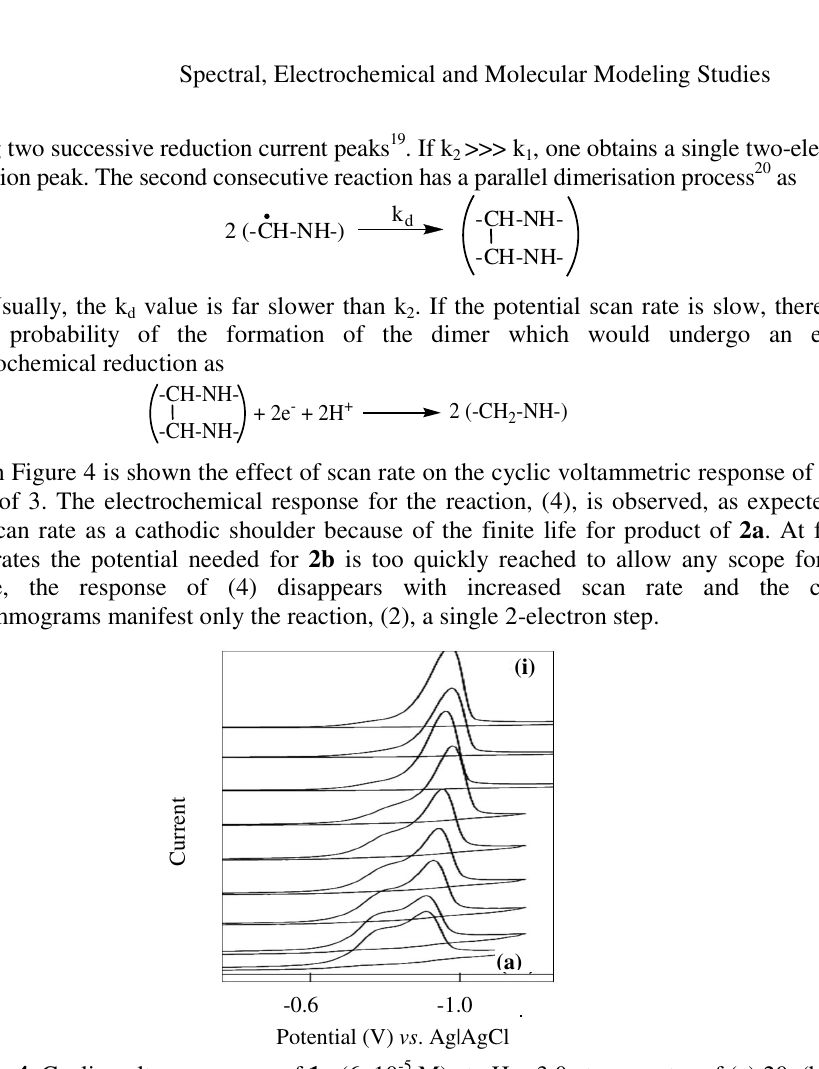
Figure 4. Cyclic voltammograms of 1a (6 x 10 -5 M) at pH = 3.0 at scan rates of (a) 20, (b) 50, (c) 100, (d) 200 (e) 500, (f) 1000, (g) 2000, (h) 4000 and (i) 5000 mV s -1